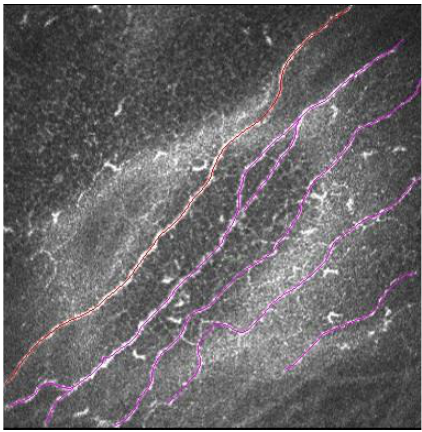
Figure 5. Sub-basal nerve plexus in LASIK patient. In red is marked a main corneal nerve, and in pink are marked secondary corneal nerves with ramifications.